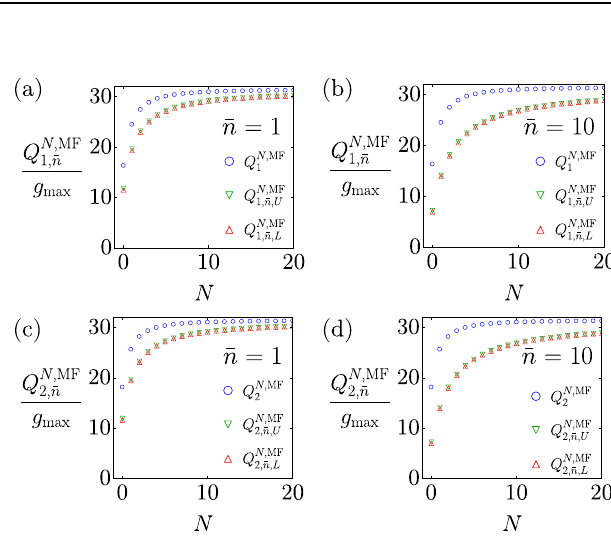
Fig. 4 | Quantum capacities of maximally fl at transducers under thermal loss. a Continuous-time one-way thermal-loss capacity upper and lower bounds with mean thermal photon number (cid:2) n =1. b Continuous-time one-way thermal-loss capacity upper and lower bounds with mean thermal photon number (cid:2) n =10. c Continuous-time two-way thermal-loss capacity upper and lower bounds with mean thermal photon number (cid:2) n =1. d Continuous-time two-way thermal-loss capacity upper and lower bounds with mean thermal photon number (cid:2) n =10. We also show the pure-loss capacities Q N ,M F 1 and Q N ,M F 2 corresponding to (cid:2) n =0 for